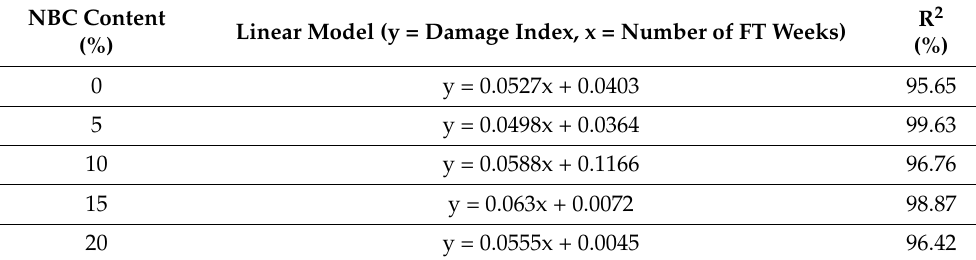
Table 5. Developed linear models between damage index and number of FT